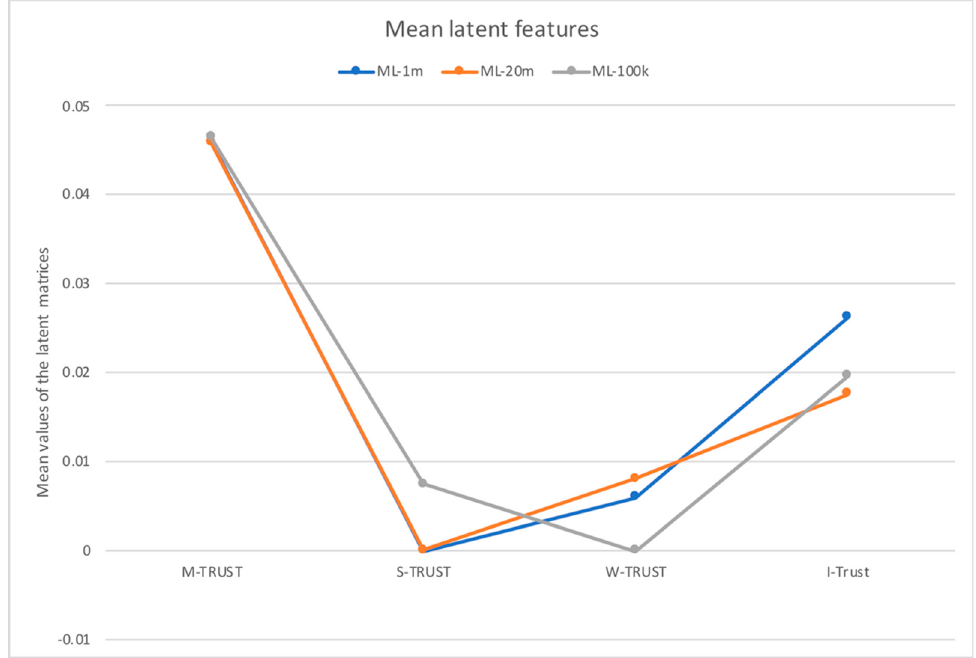
Figure 8. Mean values of latent matrices in proposed methods.